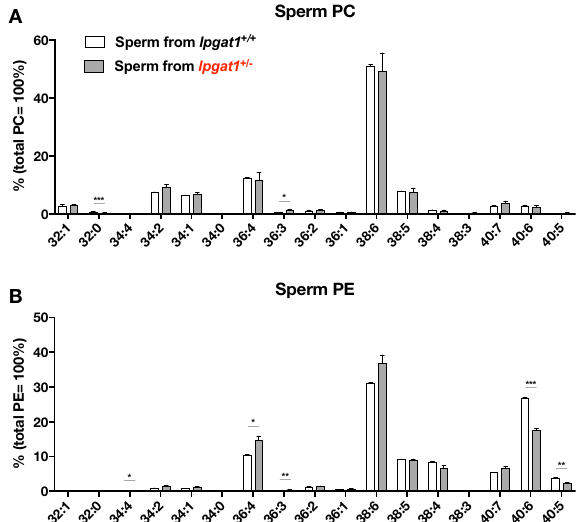
Figure 7. Phosphatidylcholine (PC) and phosphatidylethanolamine (PE) species in sperm from lpgat1 +/− zebrafish. PC ( A ) and PE ( B ) species composition of zebrafish sperm was analyzed by LC–MS/MS. Semen was collected from an anesthetized zebrafish by abdominal compression. Sperm pellets were prepared from semen collected from one zebrafish and lipids were recovered. The numbers of sperm samples were n = 4 for lpgat1 +/+ and n = 4 for lpgat1 +/− . Error bars are S.D. Statistically significant differences are marked with asterisks. * p <